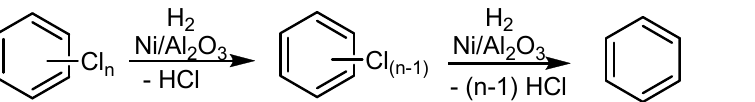
Scheme 1. HDC of (poly)chlorinated benzenes catalyzed by Ni on alumina at temperature over 200 °C